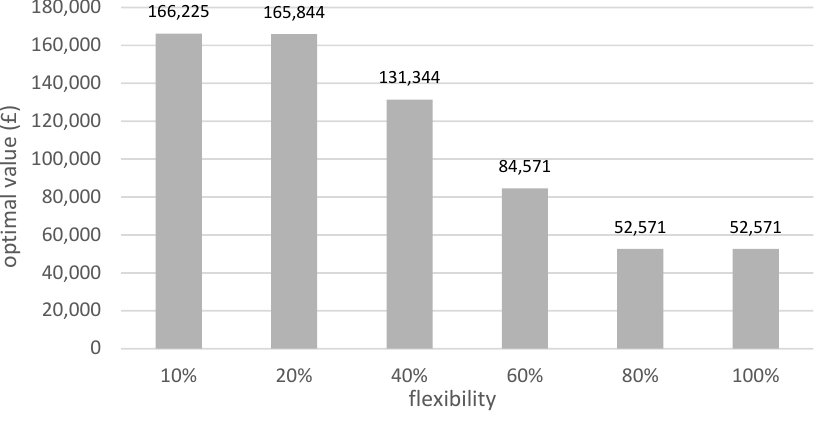
Figure 9. Optimal Value of the Objective Function as a function of the Smart Charging flexibility, using BIF.